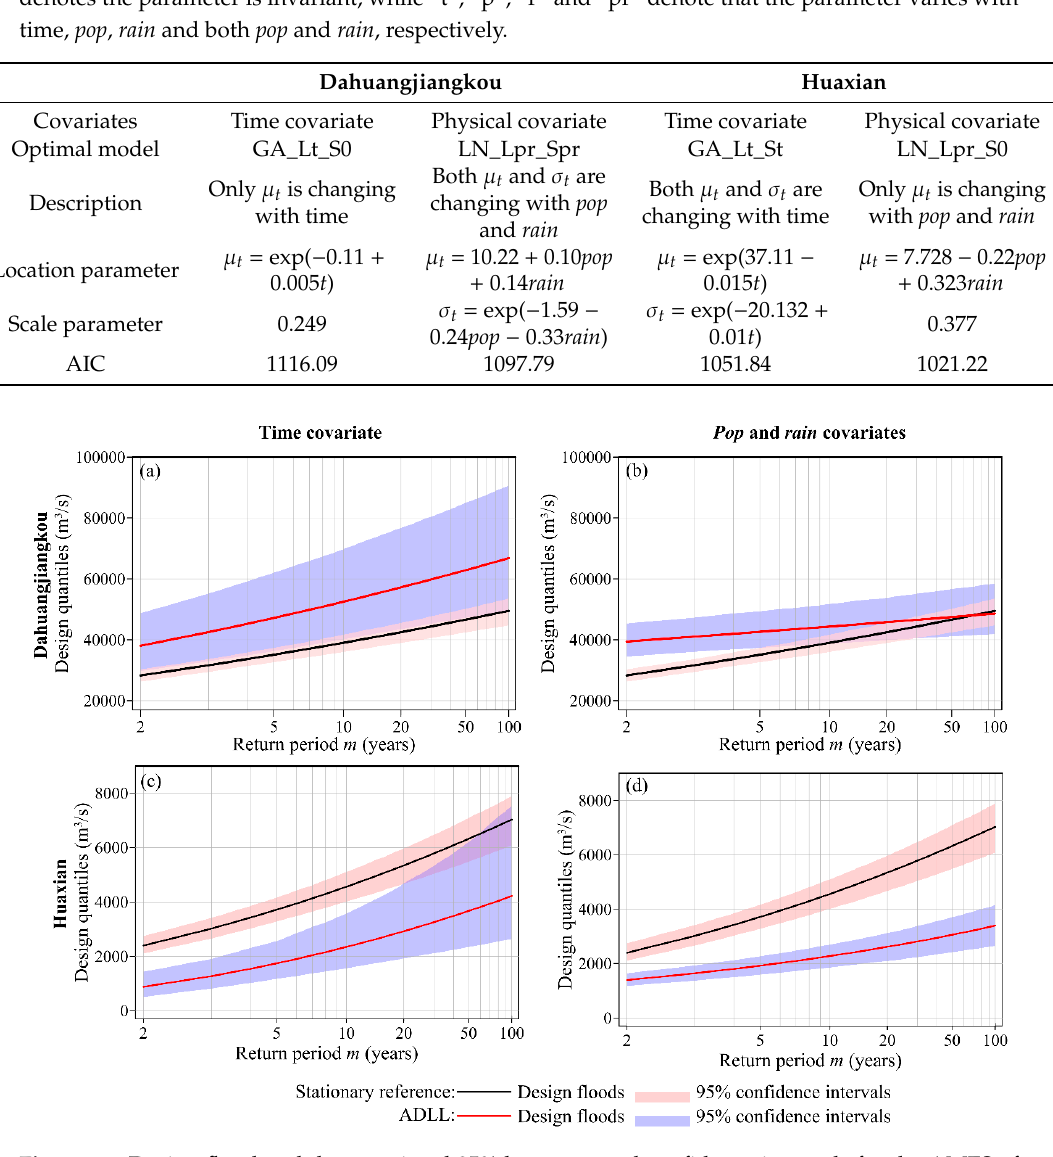
Figure 13. Design flood and the associated 95% bootstrapped confidence intervals for the AMFS of Dahuangjiangkou station (upper panel) and Huaxian station (lower panel) estimated by the average design life level (ADLL) method. ( a , c ) are estimated using time covariate while ( b , d ) are estimated using pop and rain covariates.